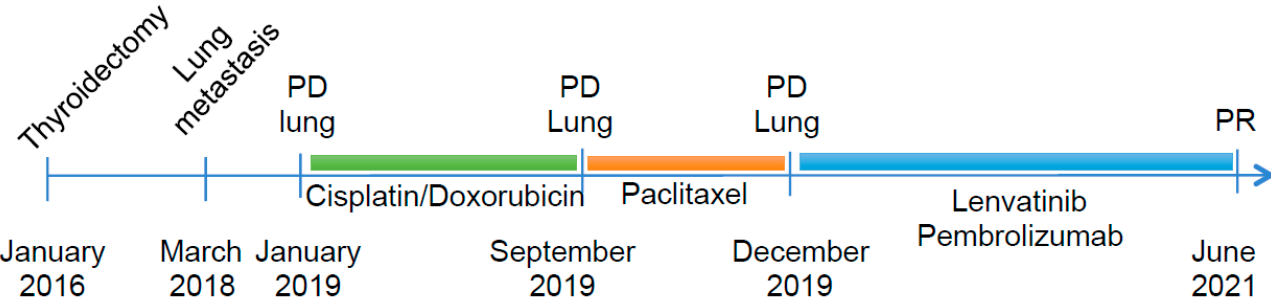
Figure 1. Schematic representation of disease progression and treatments; PD: progression disease, PR: partial response.